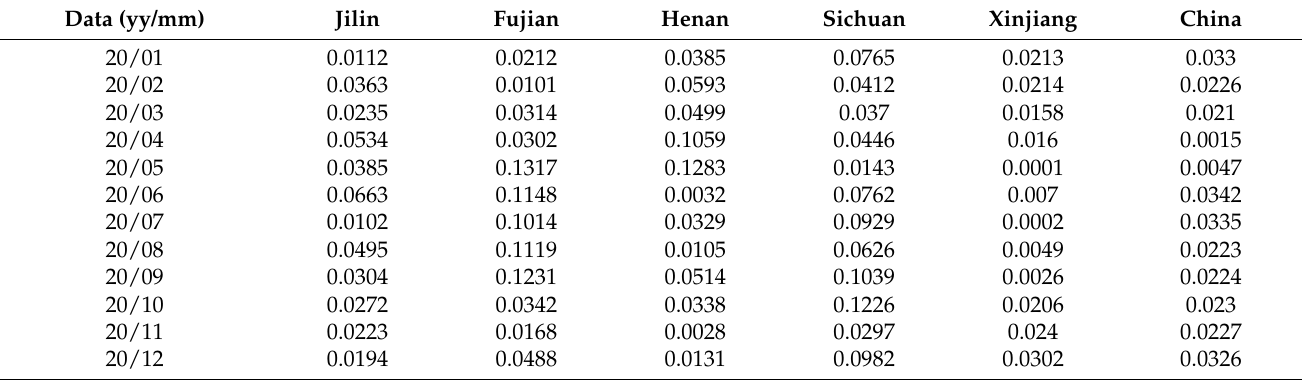
Table 4. FNDVI deviations compared with the MNDVI in different regions of